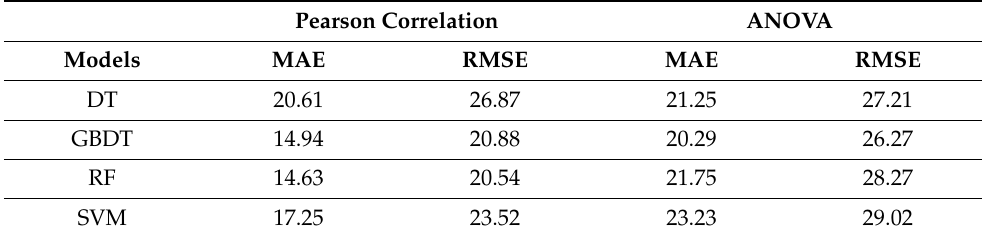
Table 3. Results of the various machine learning algorithms on the training set.